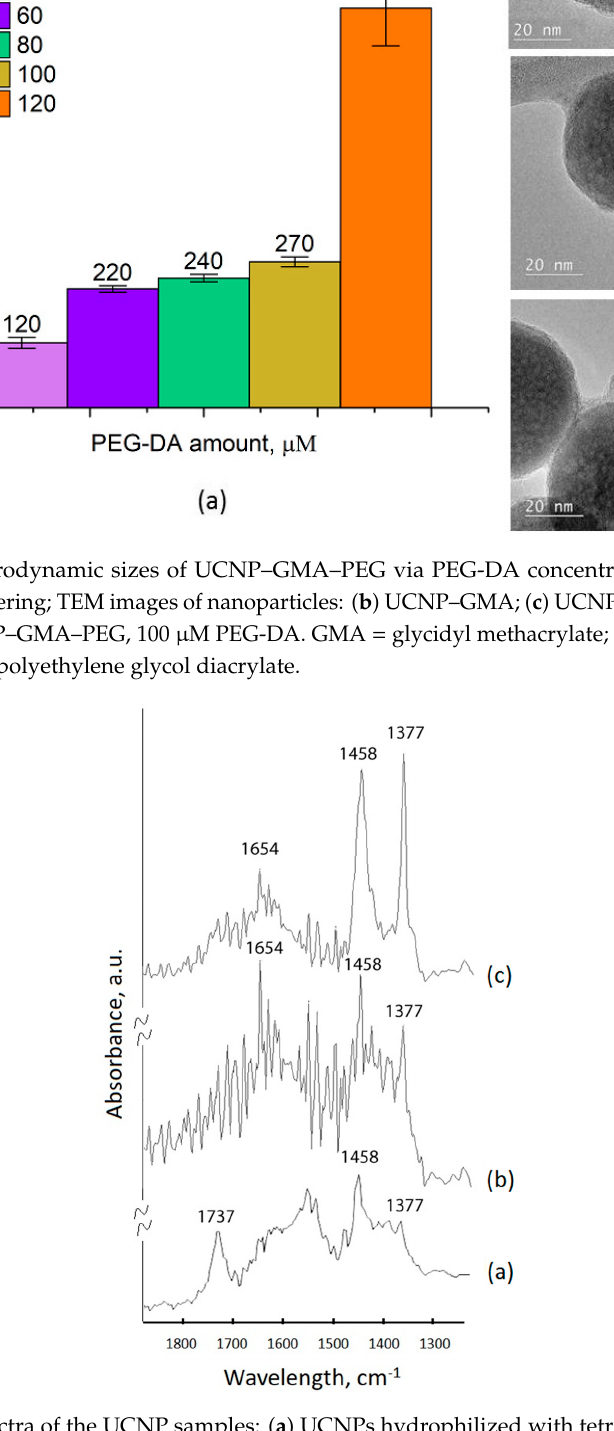
Figure 7. FTIR-spectra of the UCNP samples: ( a ) UCNPs hydrophilized with tetramethylammonium hydroxide (TMAH); ( b ) UCNP–GMA before photo-induced crosslinking; ( c ) UCNPs encapsulated in PEG-DA.